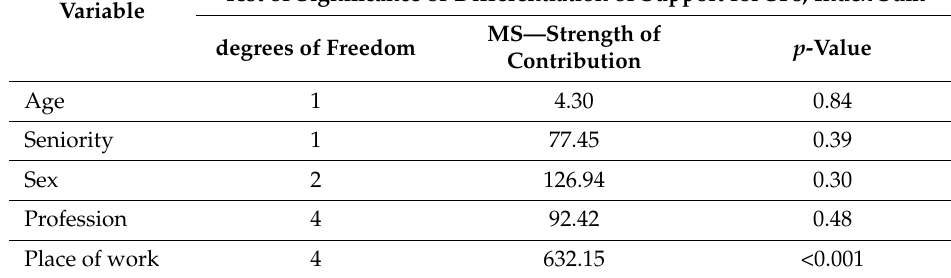
Table 3. Strength of impact of selected measurable descriptors on the support index for SPs (analysis of